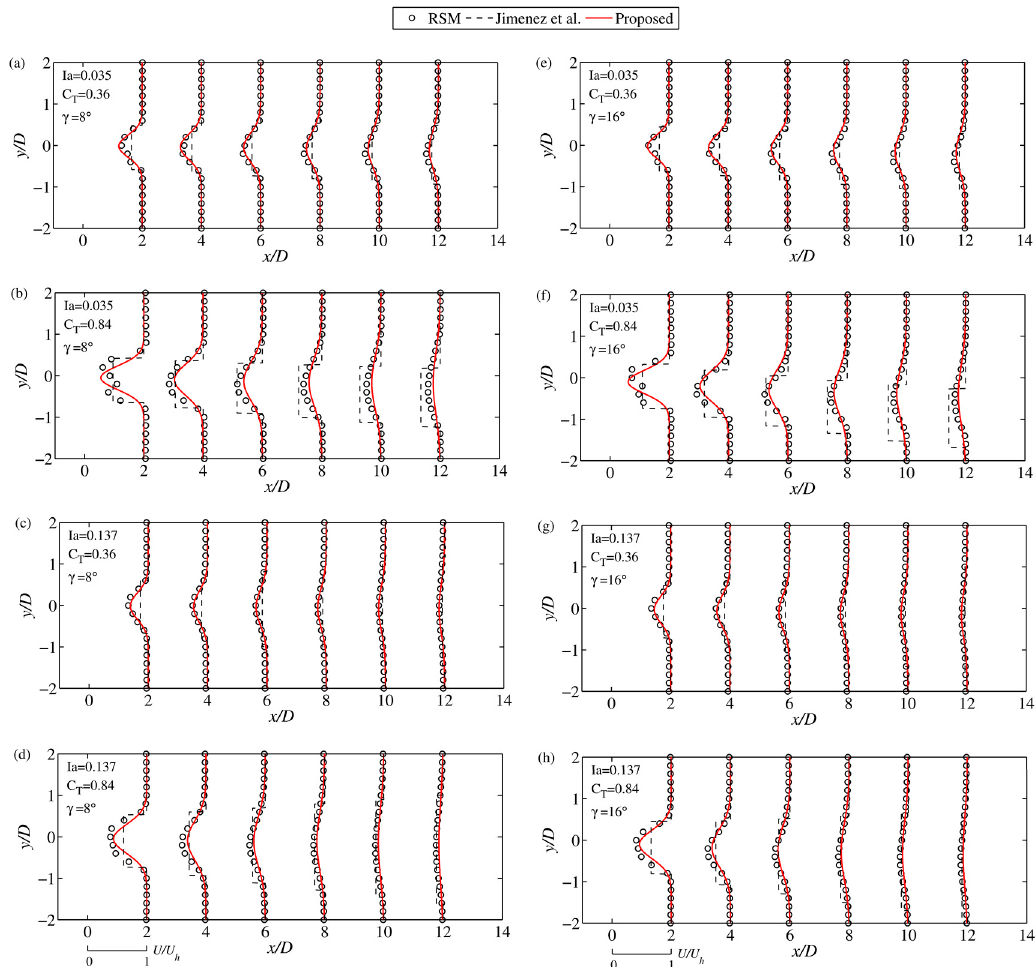
Figure 12. Validation for the predicted mean velocity under the yawed conditions.